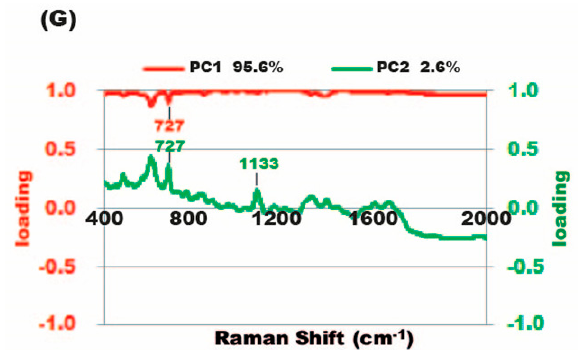
Figure 7. Diagnosis of mixed flora infections. Urine infected with both Citrobacter ferundii and Proteus mirabilis was loaded on Raman chip. ( A ) Signal peaks of 727 and 1133 cm − 1 can be seen in the Raman spectrum from the urine of a patient with mixed Citrobacter and Proteus infection; ( B ) Raman spectrum of known Citrobacter in urine sample showed a specific signal peak at 731 cm − 1 ; ( C ) Raman spectrum of Proteus showed specific signal peaks at 727 and 1133 cm − 1 ; ( D ) Raman spectrum of E. coli showed a signal peak at 729 cm − 1 ; ( E ) Raman spectrum of Pseudomonas aeruginosa showed a signal peak at 725 cm − 1 ; ( F ) PCA showed that four different known bacteria were spotted in different locations of the plot, and the PCA-spot patient with mixed Citrobacter and Proteus infection was deposited near the locations of Citrobacter and Proteus ; ( G ) PC1 and PC2 loading plots corresponding to the PCA of (F).